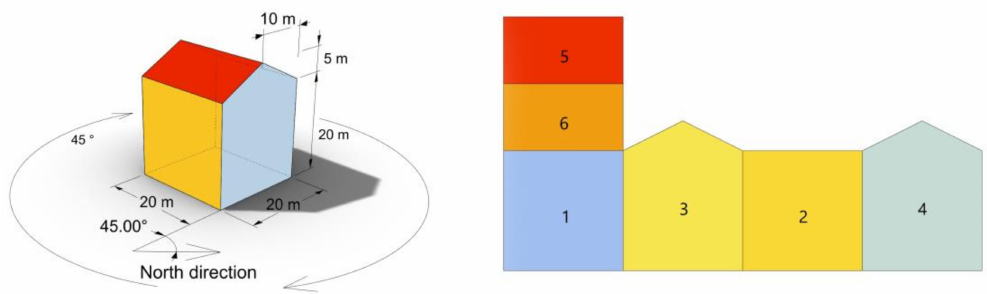
Figure 5. The model of the house with all dimensions and its geometry unfolded with numbered